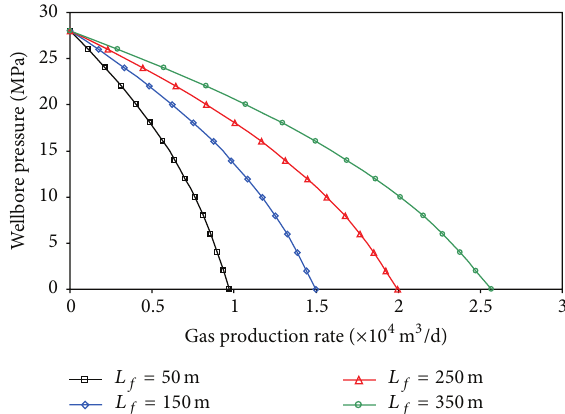
Figure 9: Effect of slippage factor 𝑏 on